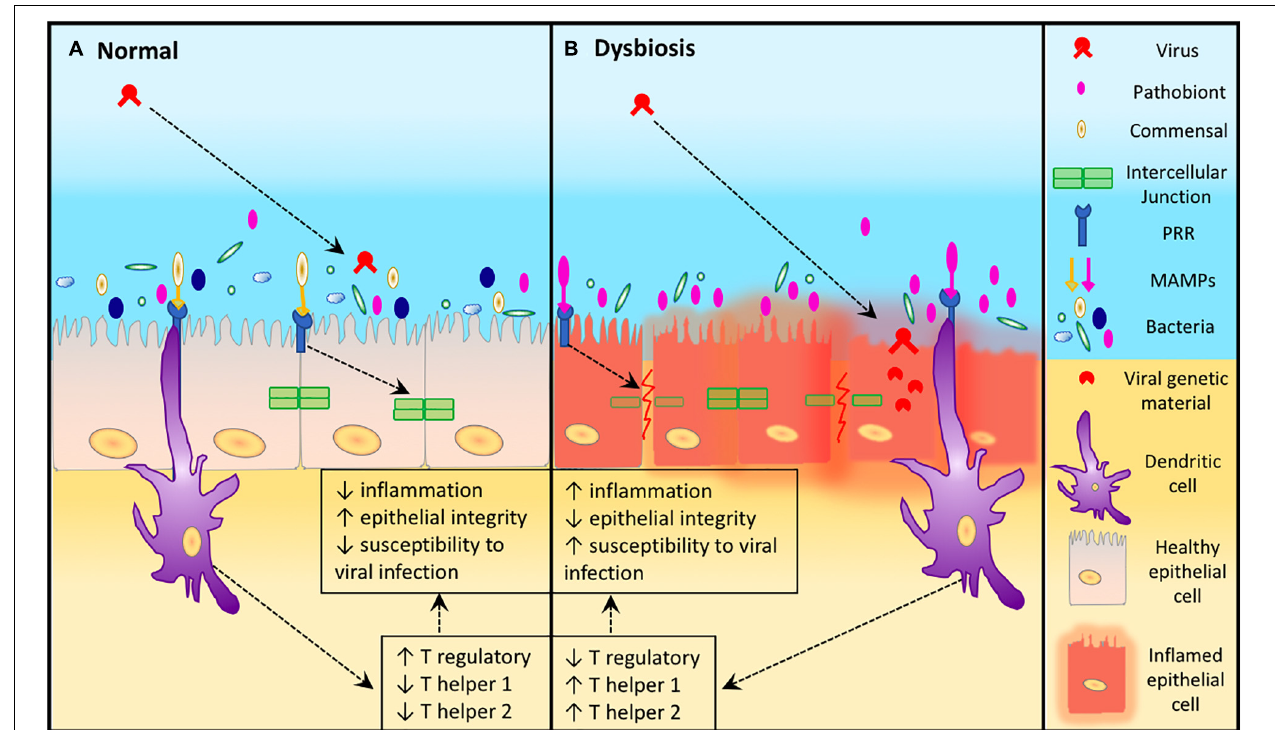
FIGURE 1 | Epithelial susceptibility to viruses during dysbiosis. (A) In a healthy URT where there is a diverse microbiota, higher numbers of commensal Microorganism-Associated Molecular Patterns (MAMPs) are able to attach to the Pattern Recognition Receptors (PRRs) of epithelial and dendritic cells resulting in maintenance of epithelial integrity and reduced susceptibility to viral infection. (B) Dysbiosis in the URT leads to an increase abundance of a pathobiont which increases the attachment of pathobiont MAMPs to the PRRs of epithelial and dendritic cells resulting in increased inflammation, reduced epithelial integrity. This leads to host cell damage which increases the susceptibility of host URT to viral